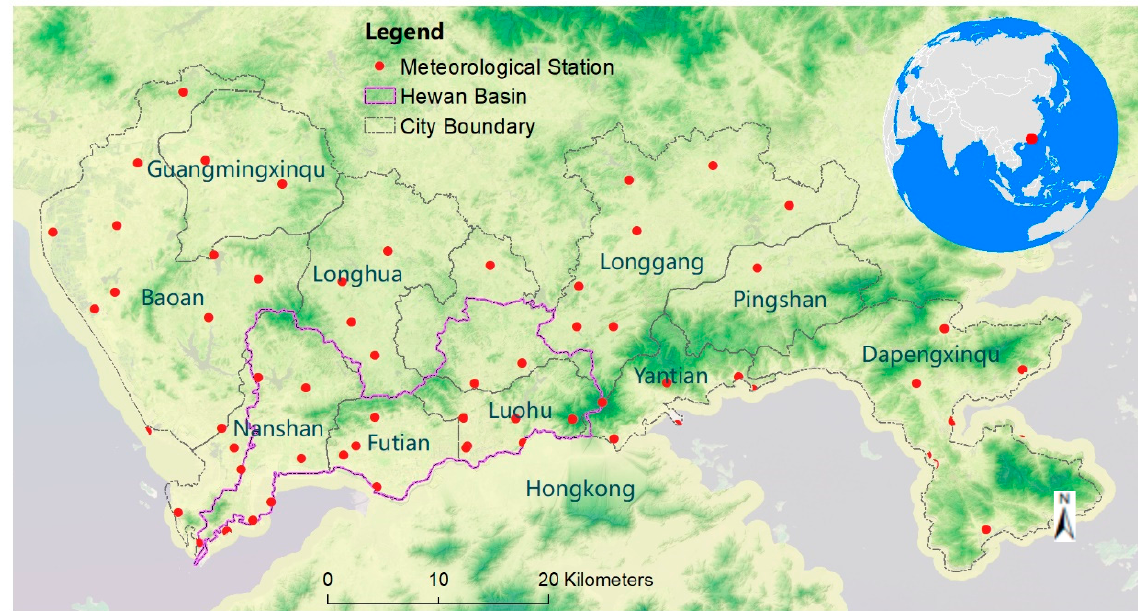
Figure 1 . Study area and distribution of the automated weather stations